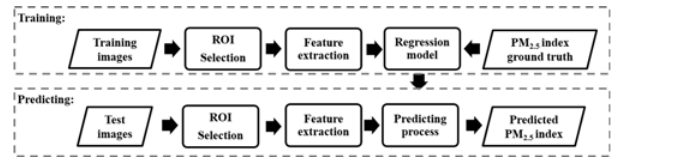
Fig 3. PM estimation via outdoor image analysis.